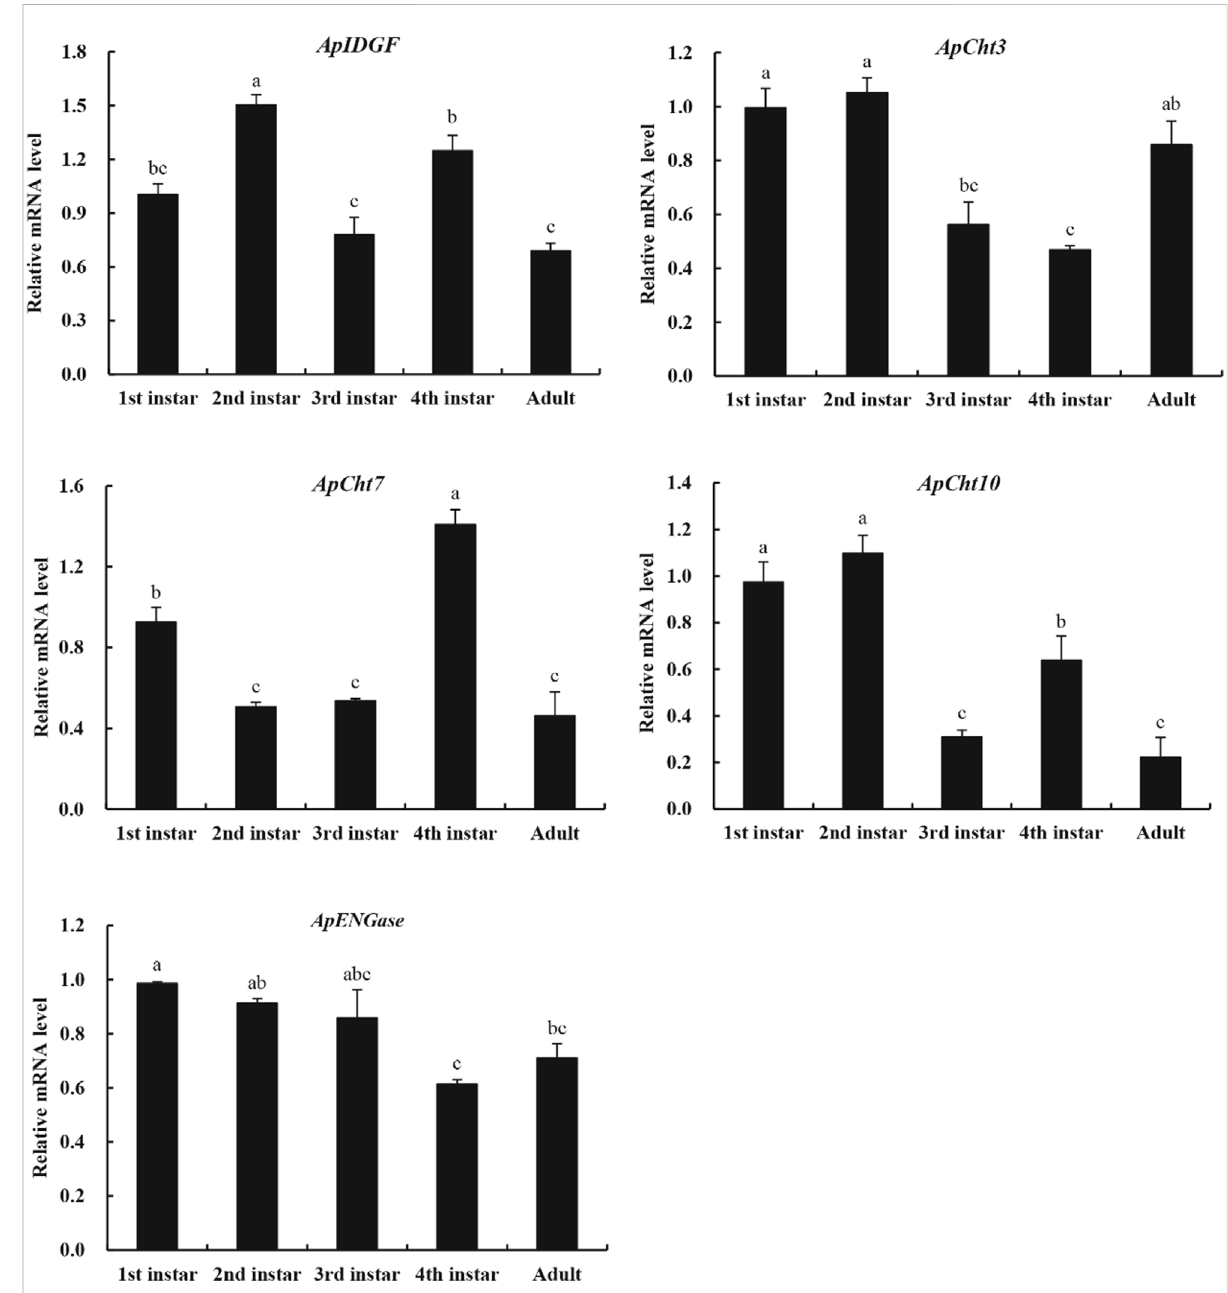
FIGURE 4 Developmental expression patterns of chitinase genes. Different letters on the top of the columns indicate signi fi cance in the difference of expression levels by Tukey ’ s HSD test ( p <